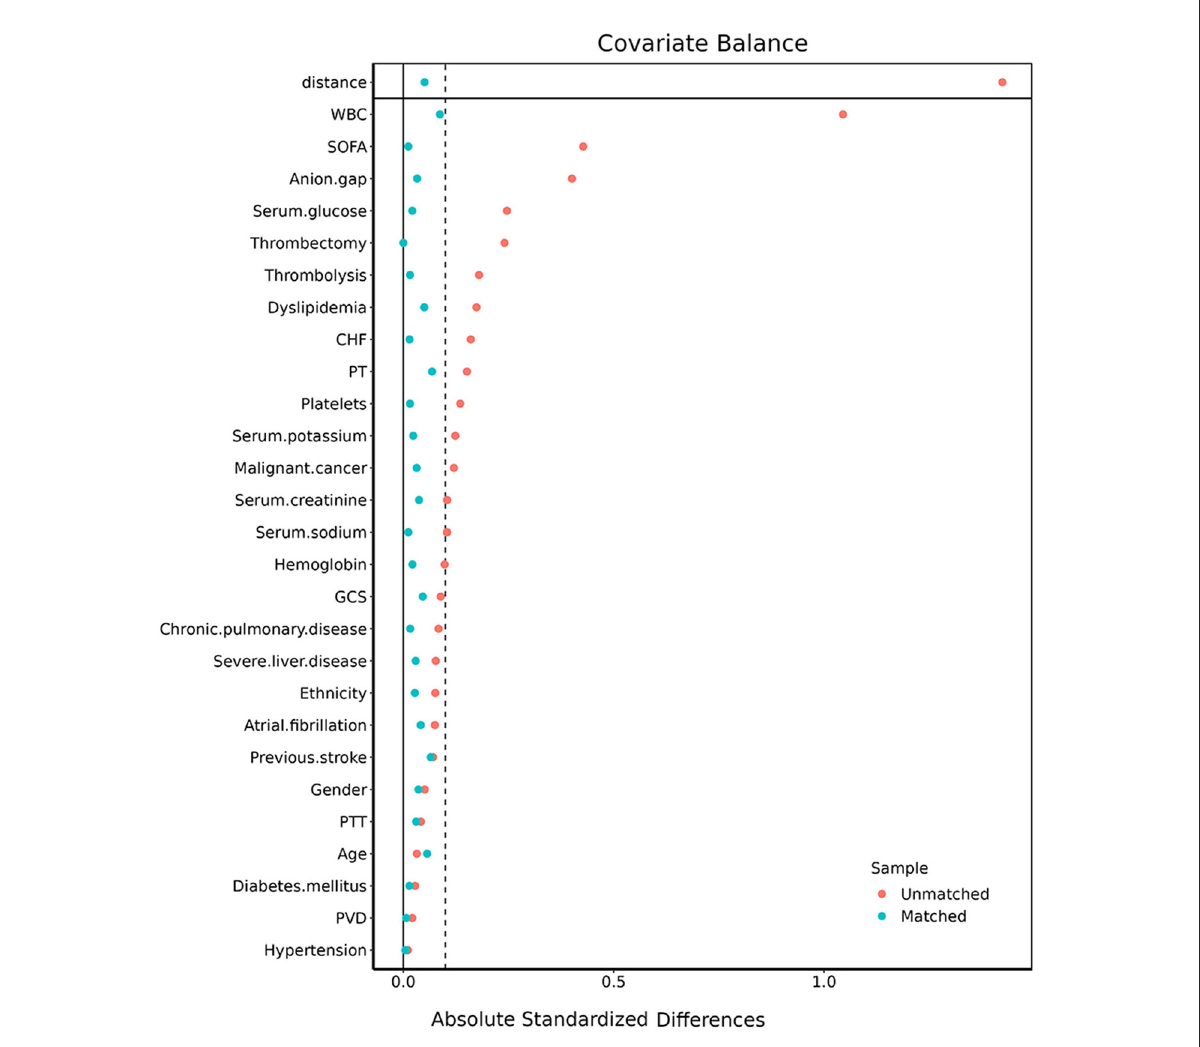
FIGURE5 The absolute standardized differences for variables used to match the two